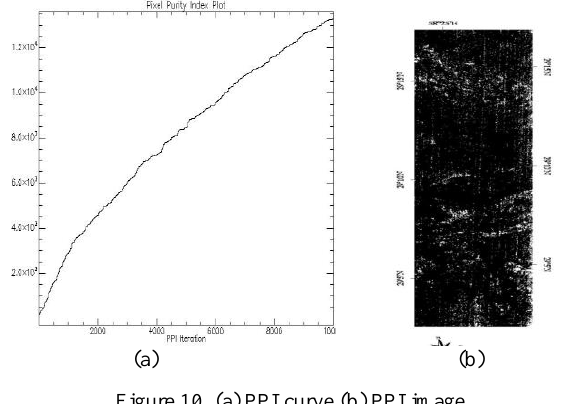
Figure 10. (a) PPI curve (b) PPI